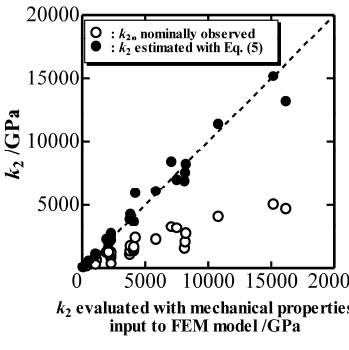
Figure 3. Indentation unloading parameter k 2 simulated and k 2n nominally observed plotted against k 2 evaluated with mechanical properties inputted into the FEM model.